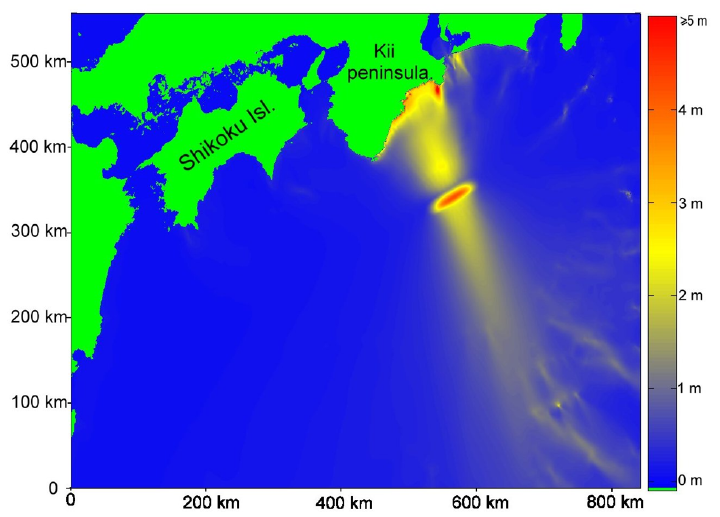
Figure 10. Distribution of wave height maxima as the result of a tsunami wave generated by the source S3-b (see Figure 3).